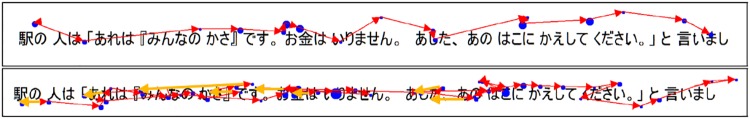
Eye gaze of 2 readers reading the same text.The fixations are represented by a blue dot which diameter depends on the duration: the more the reader looked at a specific region of the text, the bigger the dot is. The saccades between 2 fixations are represented by red strokes which direction is indicated by the arrow. The backward saccades (regressions) are represented in yellow. The first reader (upper part) understood the content of the text and the second did not understand the content of the text.